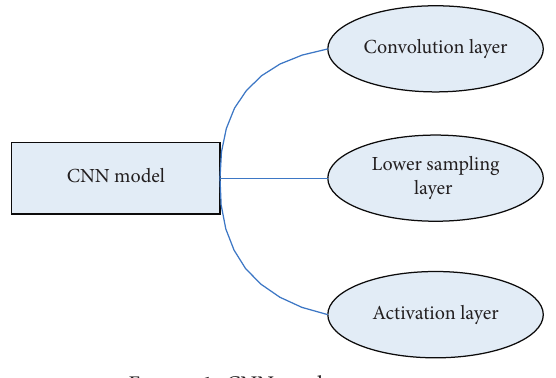
Figure 1: CNN mode